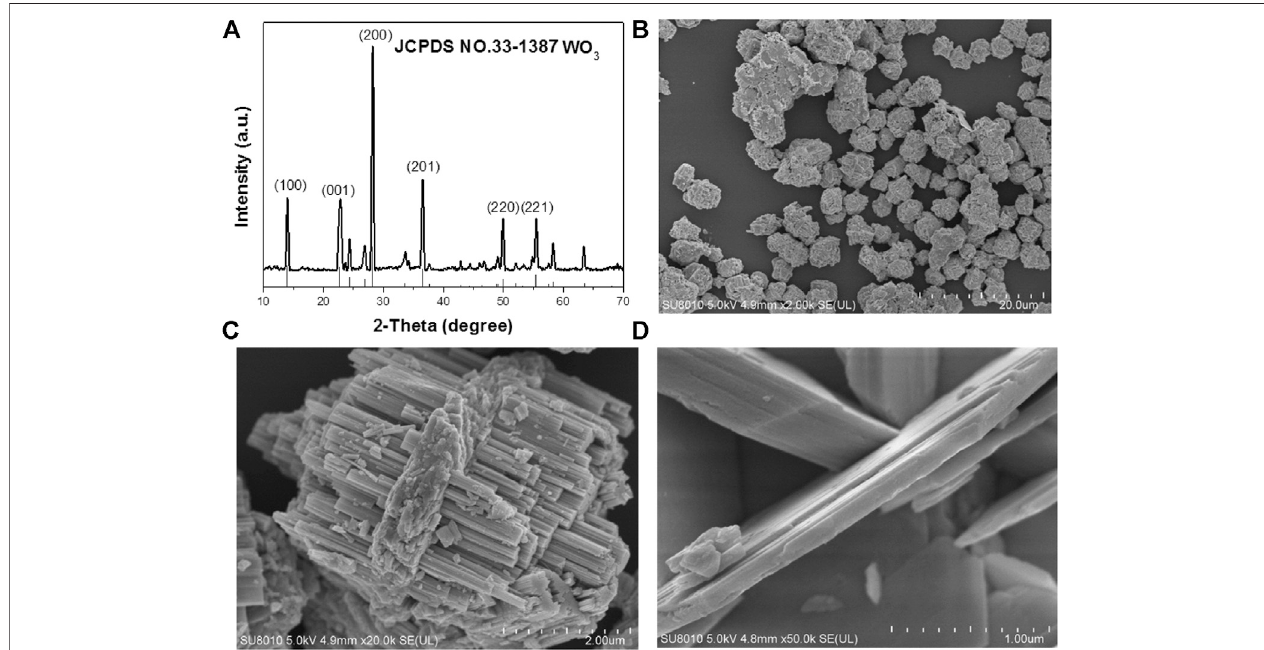
FIGURE1 |(A) Powder XRDpatternsofthe as-preparednanocrystals and the standard WO 3 powders. (B) TheSEM images of theWO 3 nanocrystals. (C) Typical SEM images of the WO 3 nanocrystals. (D) Ampli fi cation SEM of WO 3 nanocrystals.